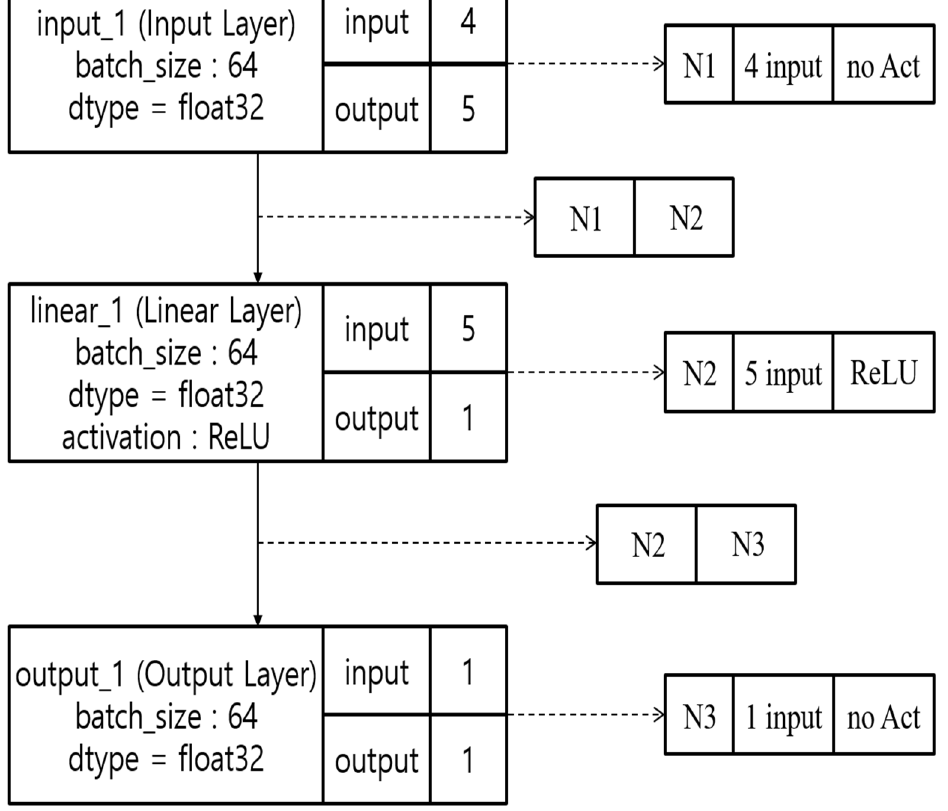
Figure 3. Initial architecture. Figure 3. Initial Table 2. Parameters of experiment.